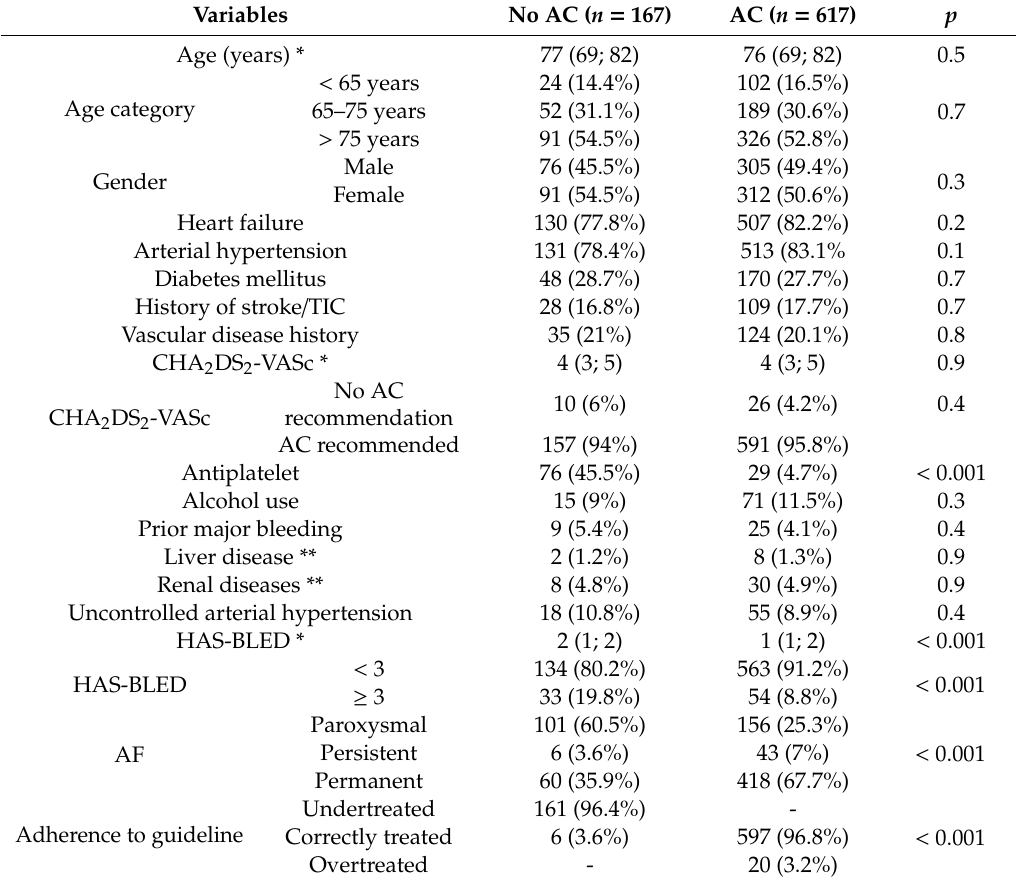
Table 1. Patients characteristics in relation to AC therapy.